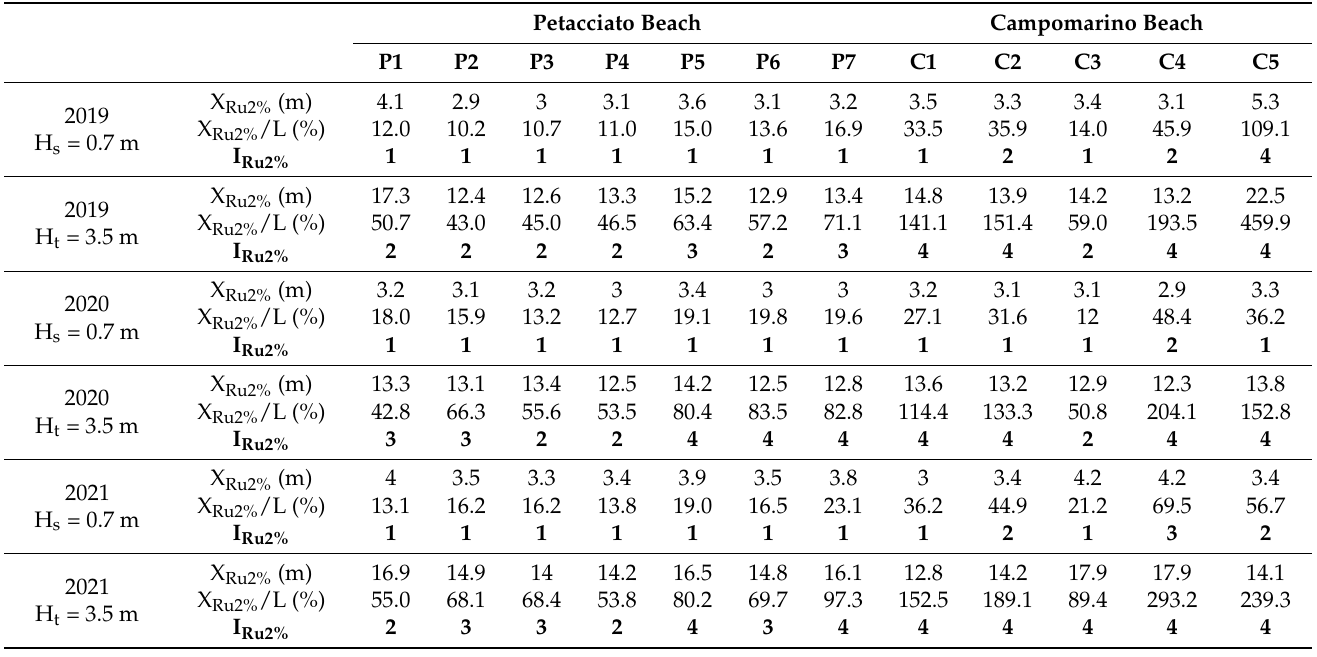
Table 8. Estimated run-up index values I Ru2% and related parameters X Ru2% and X Ru2% /L under